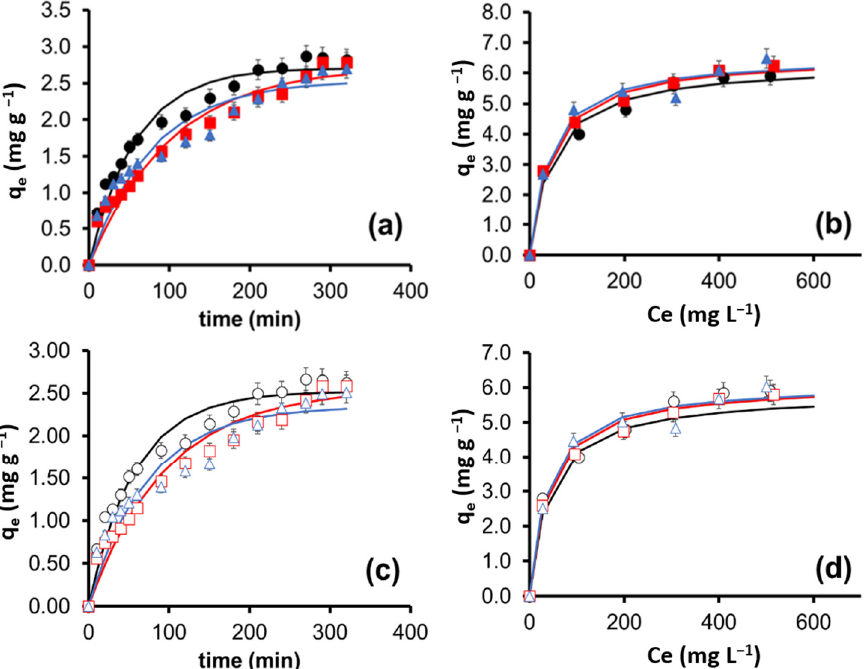
Figure 6. Batch adsorption studies of DB-86 onto adsorbents prepared from agave bagasse fibers: biosorbent material: ( a ) Adsorption kinetics studies, ( b ) Adsorption equilibrium studies; hydrochar material: ( c ) Adsorption kinetics studies, ( d ) Adsorption equilibrium studies. Experimental conditions: 0.40 ± 0.01 g of adsorbent, 50 mL of adsorbate, pH 2, 200 rpm, equilibrium time 180 min,